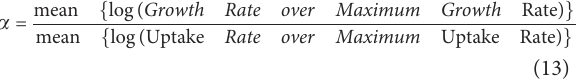
(Table S3). Monod ’ s model (blue line) fails to explain changes in the growth rate and substrate concentration, while the Droop variable quota model (green line) and Monod-memory model (black line) closely follow the trend in the data (red dots, n = 30, Figure 1 for t< 5, Figure S4). The MSE for the Droop model, which was used to generate the simulated data, is somewhat smaller than the MSE for the Monod-memory model; both are clearly superior to the MSE for the Monod